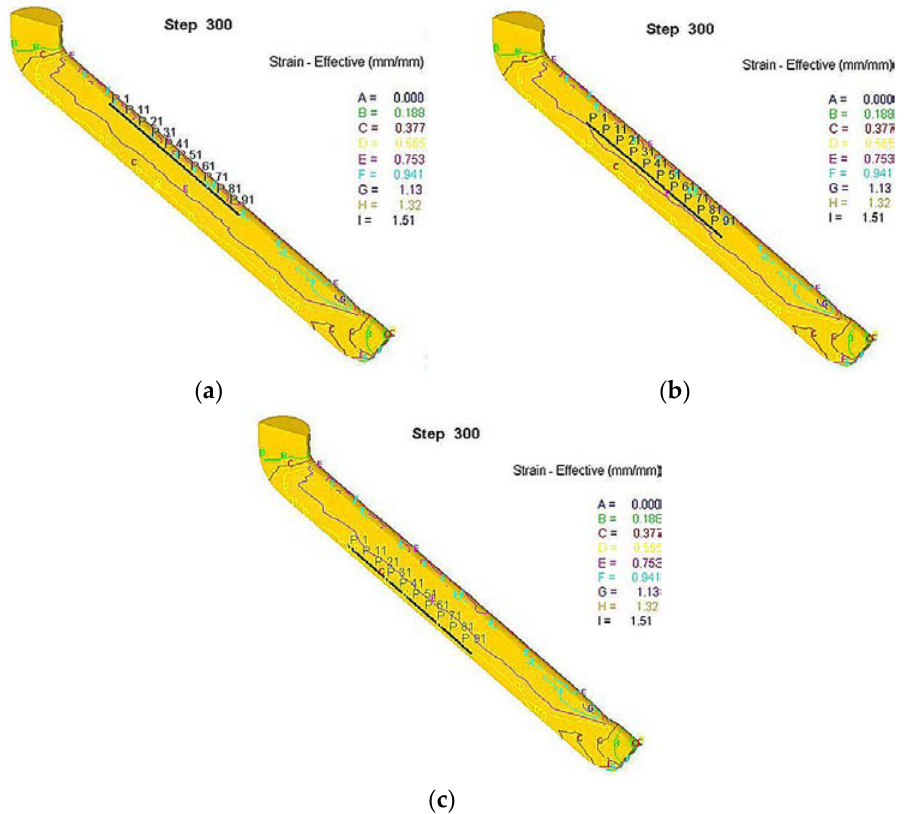
Figure 4. Variable point tracking of effective strain at different positions in plane C: ( a ) upper zone; ( b ) middle zone; and ( c ) lower zone.